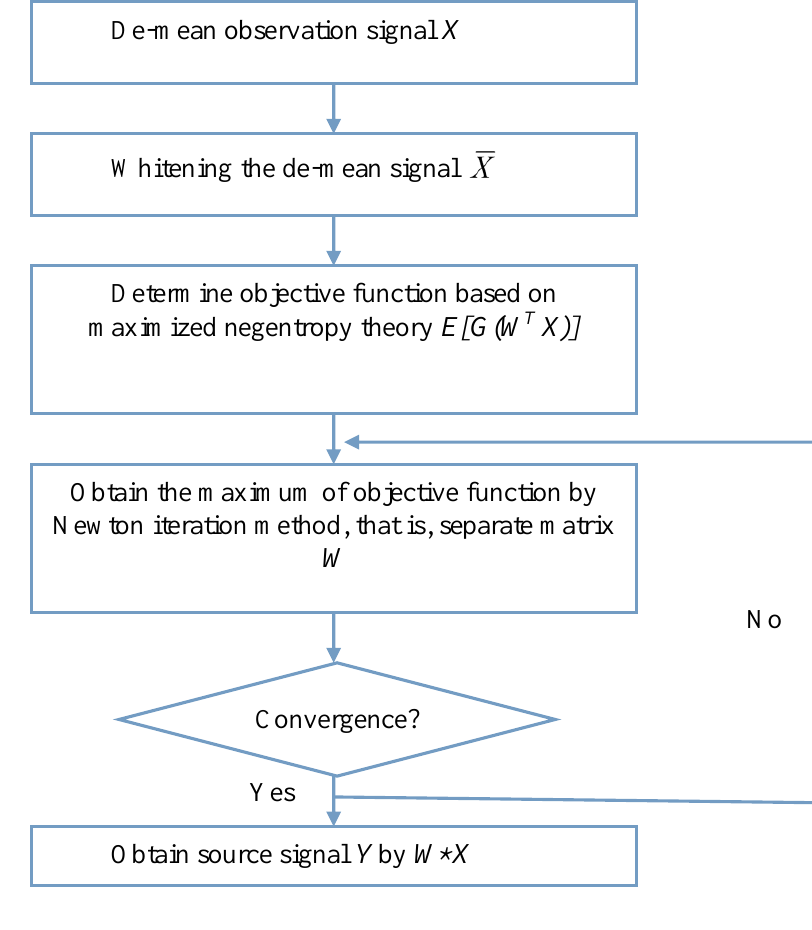
Fig. 1. Processing steps of